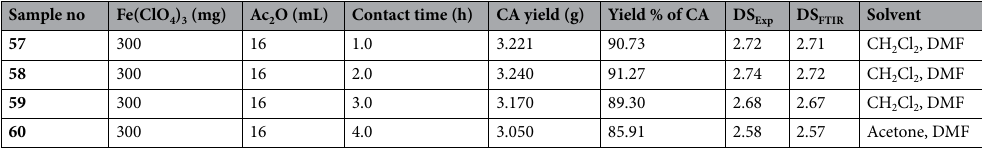
Table 1. Acetylation of MCC (2.0 g) using acetic anhydride in presence of Fe(ClO 4 ) 3 ·xH 2 O (50, 100, 200, and 300 mg) at room temperature and different times (0.5–4 h).